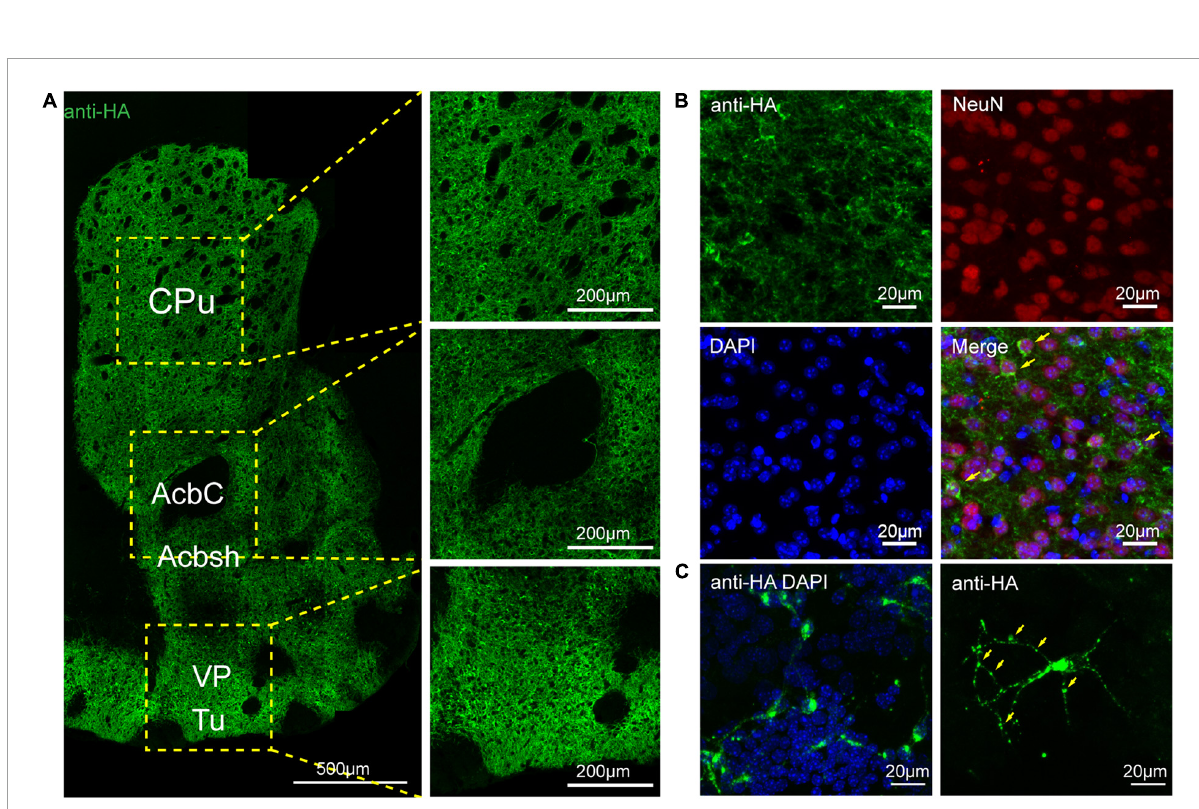
FIGURE4 Distribution of HA immunoreactivity in the forebrain of adenosine A 2 A receptor (A 2A R)-tag mice. (A, Left) Representative confocal image of HA expression in the forebrain (1.18 mm before bregma). Dense labeling of the neuropil can be seen in the striatum, nucleus accumbens, ventral pallidum, and olfactory tubercles. (Right) High magnification of the areas in yellow indicated in panel (A) . Numerous labeled cells could be seen within the neuropil. (B) Double-labeling immunofluorescence experiment showed that anti-HA positive cells (green) were neurons (red) in the striatum. Notably, fluorescence seemed to be mostly localized to the plasma membrane (arrows), and the staining signal was denser in some areas at the cell membrane. (C) In fully mature primary neurons (6 days in culture) from A 2A R-tag mouse, HA immunoreactivity displayed polarized localization in the cell body and a punctate pattern in the processes (arrows). CPu, caudate putamen (striatum); AcbC, accumbens nucleus, core; Acbsh, accumbens nucleus, shell; VP, ventral pallidum; Tu, olfactory tubercles. Scale bars as indicated in each